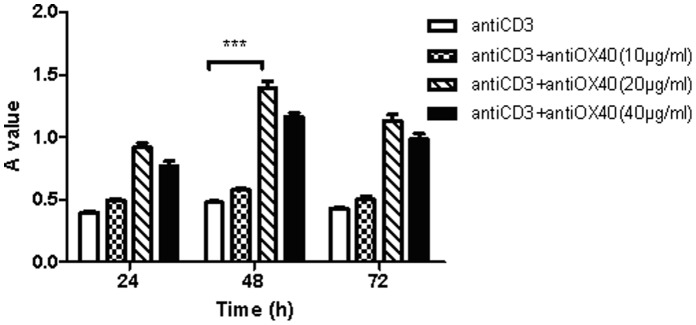
The proliferation of lymphocytes at 24 h, 48 h and 72 h after stimulated OX40-OX40L interaction by anti-OX40 (10, 20, 40 µg/ml).***p<0.001 compared to respective control.